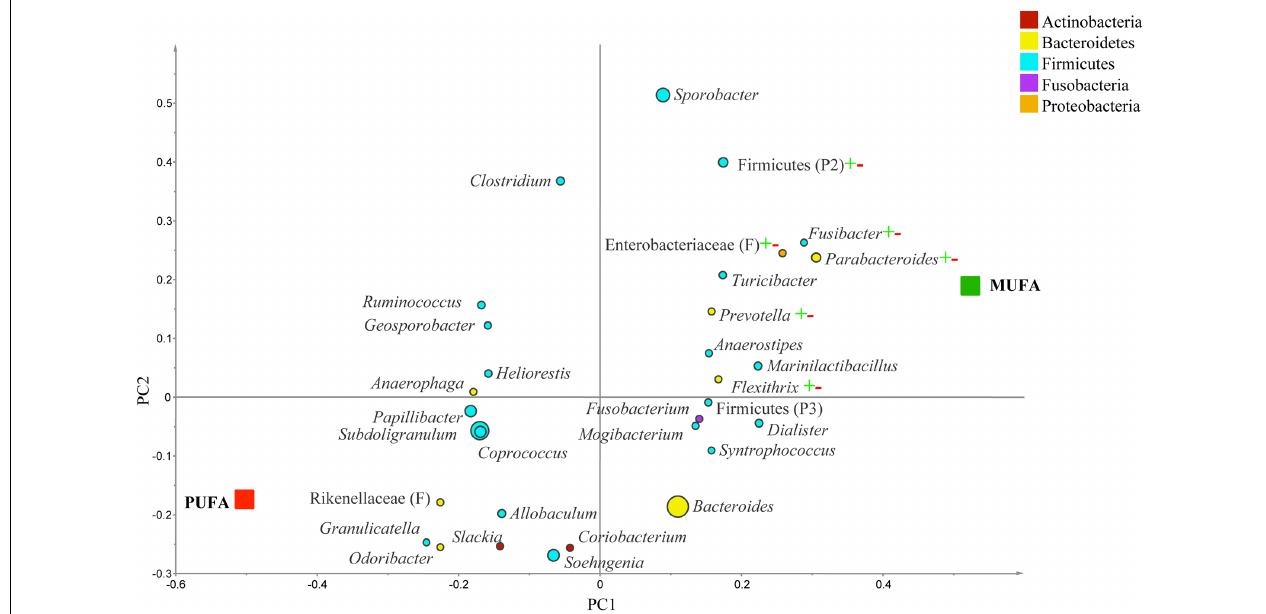
FIGURE 6 | Partial least square discriminant analysis (PLS-DA) loading plot based on the relative abundances of bacterial genera in the gut microbiota and their association with MUFA-rich or PUFA-rich diets in obese population (BMI > 30). The presenting genera are chosen at VIP cutoff of 1.0 and colored according to their corresponding phyla. The size of circles is indicative of taxa abundance. Taxa closer to MUFA or PUFA indicate positive association with either treatment group. The R 2 ( = 0.66) and Q 2 ( =− 0.20) estimates were calculated based on three components. While majority of sequences were identified at the genus level (G), some could only be affiliated to phylum (P) class (C), order (O), or family (F)